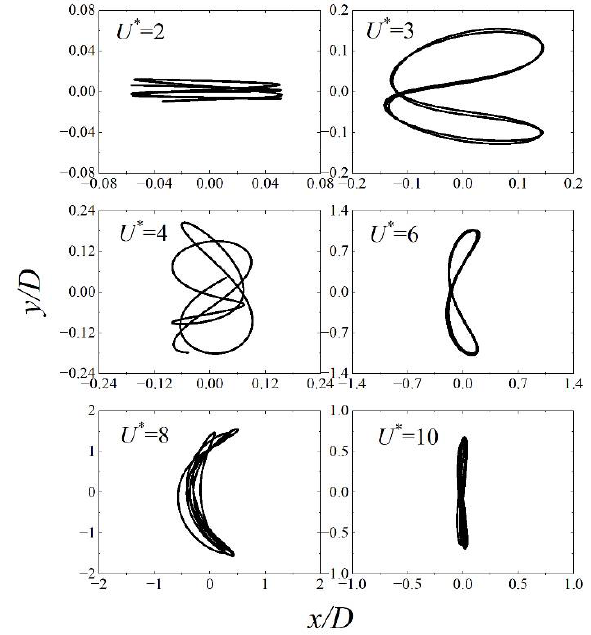
Figure 8. Typical VIV trajectories at selected reduce velocities.